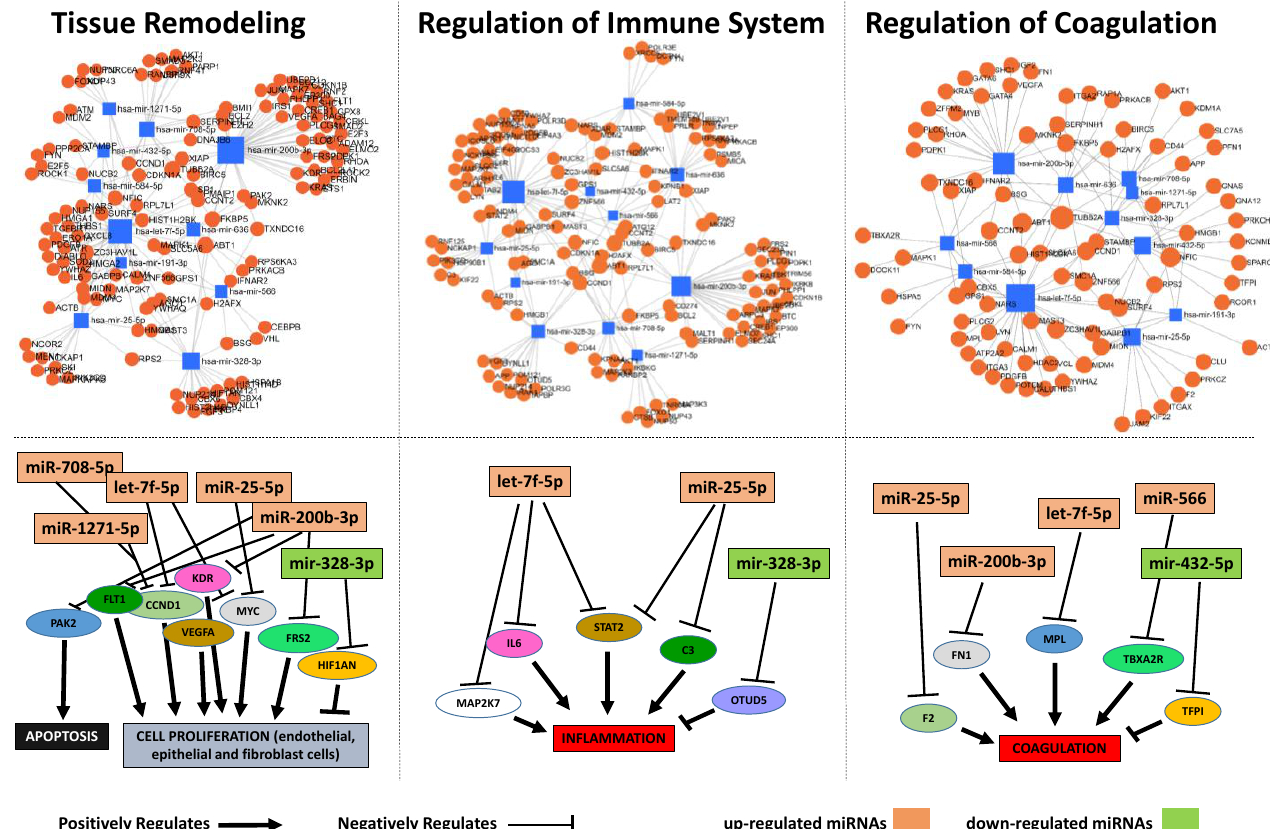
Figure 4. Protein–protein interaction network generated for shared miRNA target genes after miRNET analysis. Top images show networks with all interactions between deregulated miRNAs and genes involved in tissue remodeling, regulation of the immune system and regulation of coagulation. Bottom images show schematic representation of crucial proteins involved in the regulation of each pathway and their interaction with some deregulated miRNAs. Table 2. Top ranked miRNAs and genes found in the network